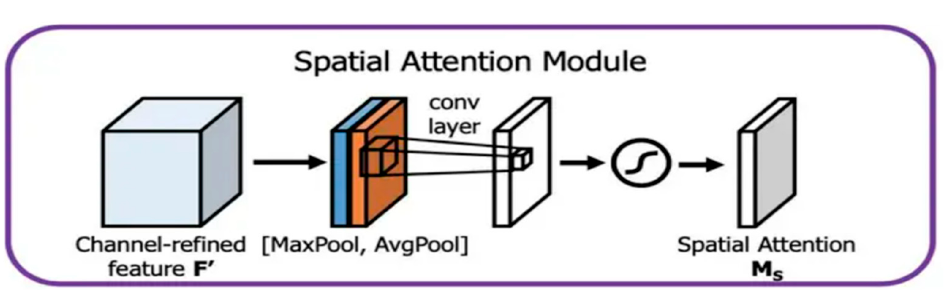
Figure 9. Spatial attention mechanism.